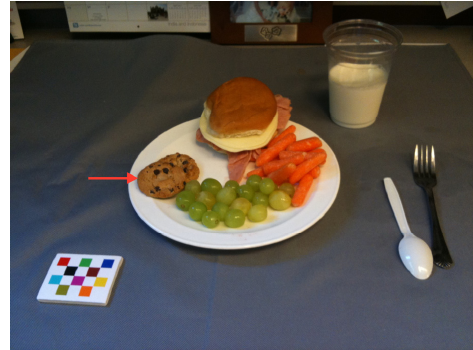
Figure 1. Example of an image shown to participants for the identification serving of the Diet Assessment